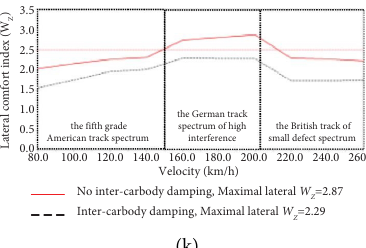
Figure 4: Tree-vehicle trainset with semiactive damping techniques between intervehicles and technical efective assessments. (a) Tree- vehicle trainset simulation of motor-trailer-motor in curing negotiation. (b) Semiactive damping device between intervehicles. (c) Lateral comfort index at rear car body MC01 under λ e � 0.03. (d) Lateral comfort index at the rear car body TC02 under λ e � 0.03. (e) Lateral comfort index at rear car body MC03 under λ e � 0.03. (f) Lateral comfort index at rear car body MC01 under λ e � 0.06. (g) Lateral comfort index at the rear car body TC02 under λ e � 0.06. (h) Lateral comfort index at rear car body MC03 under λ e � 0.06. (i) Lateral comfort index at rear car body MC01 under λ e � 0.10. (j) Lateral comfort index at the rear car body TC02 under λ e � 0.10. (k) Lateral comfort index at rear car body MC03 under λ e �